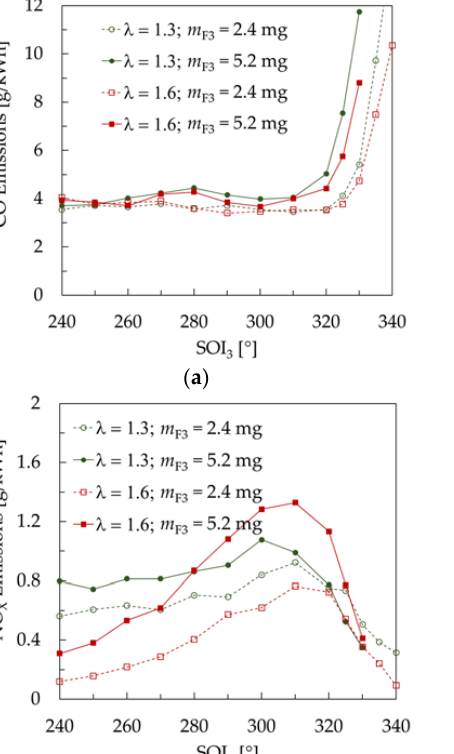
3 timing for all investigated